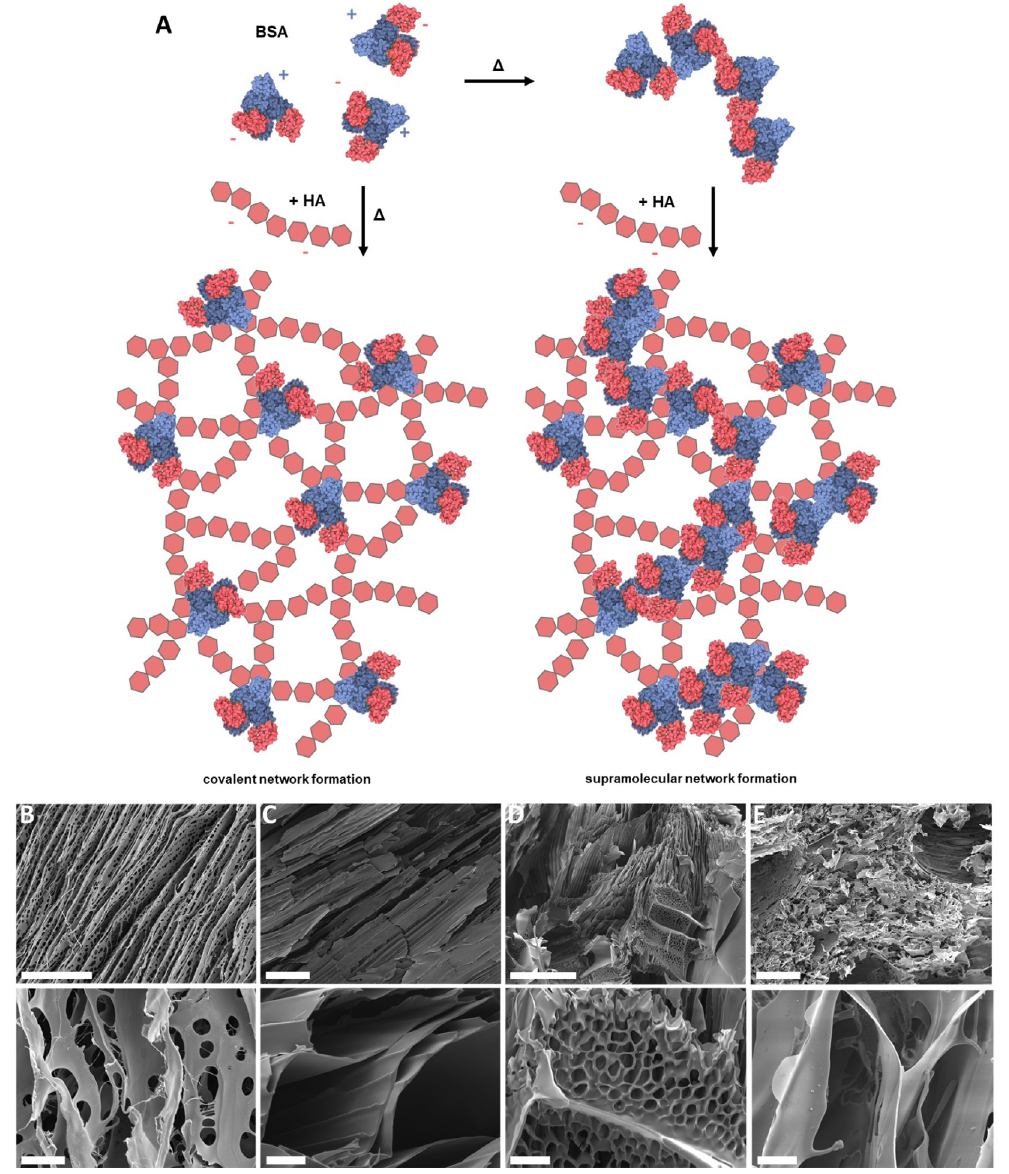
Figure 3. HA/BSA gels. ( A ) Illustration of strategies to form gels from BSA and HA. Changing the order of addition and protein concentration allows facile tuning of the mechanical and topological properties of the network. ( B – E ) SEM images of HA alone, HA/BSA (untreated and undenatured; 1:5), HA/BSA covalent gels 23 (1:5) which are not otherwise considered in this study, and supramolecular HA/BSA gels (1:5; see Figure 4). Scale bar = 100 µ m (top), 10 µ m (bottom). Dataset 1: Scanning electron microscopy